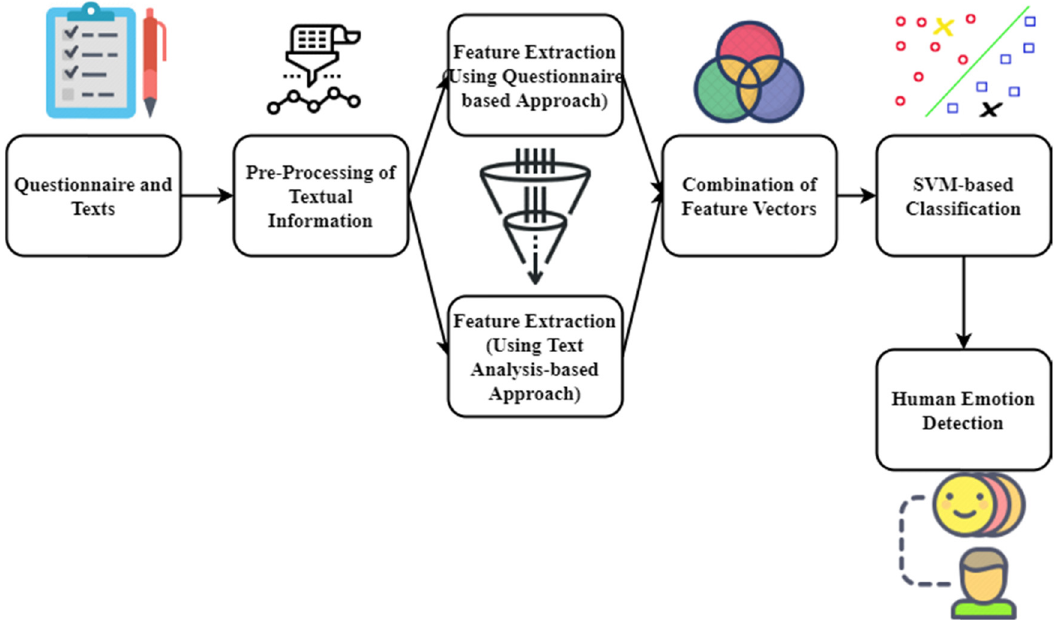
Figure 1: Proposed DLSTA